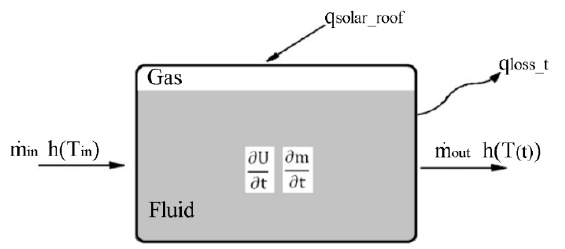
Figure 5. Simplified schematic representation of the thermal storage tank, adapted from [30]. The variation in the internal energy of the fluid was expressed as a function of time and other design parameters, as shown in Equation (23) [30]: